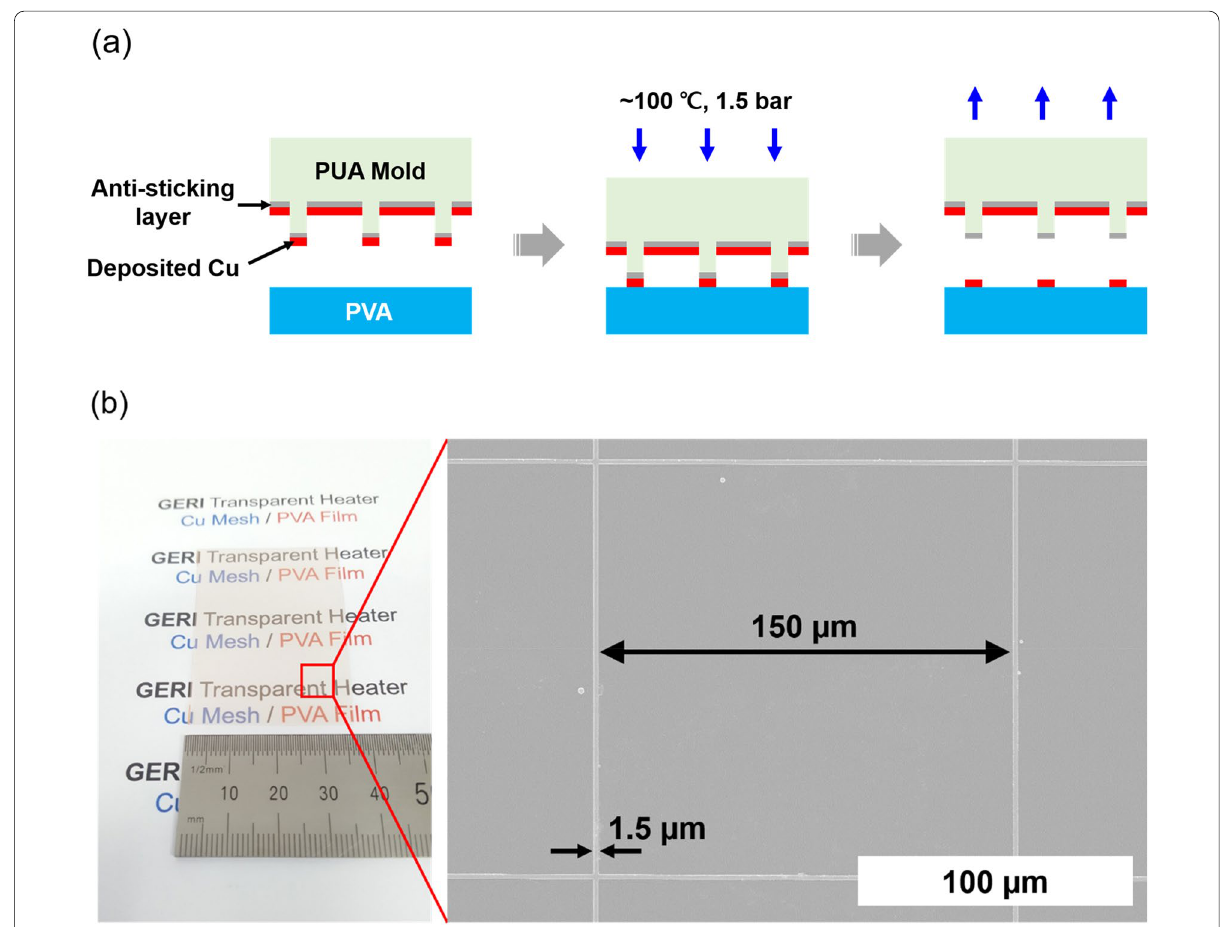
Fig. 1 a Schematic of the transfer printing process. b Photograph and surface FE‑SEM image of the Cu mesh directly printed on the PVA